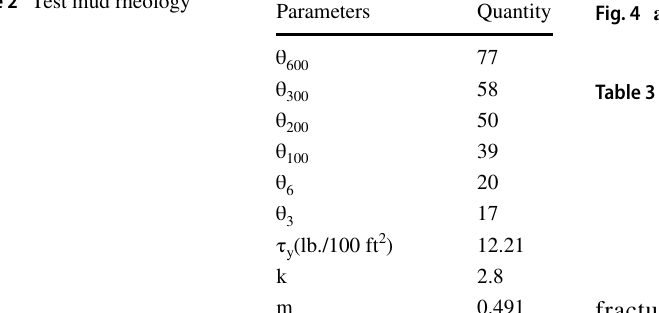
Fig. 4 a 1 mm straight cell. b 3 mm straight cell